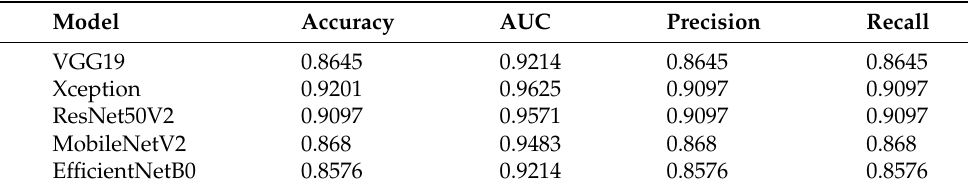
Table 8. Model performance for the best setting achieved from the ablation study.